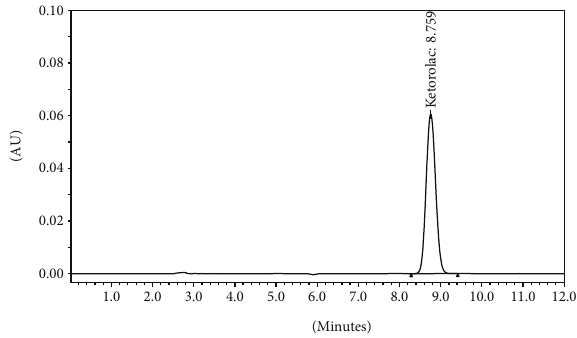
Figure 5: Chromatogram for the reference solution of ketorolac in wastewater determination.